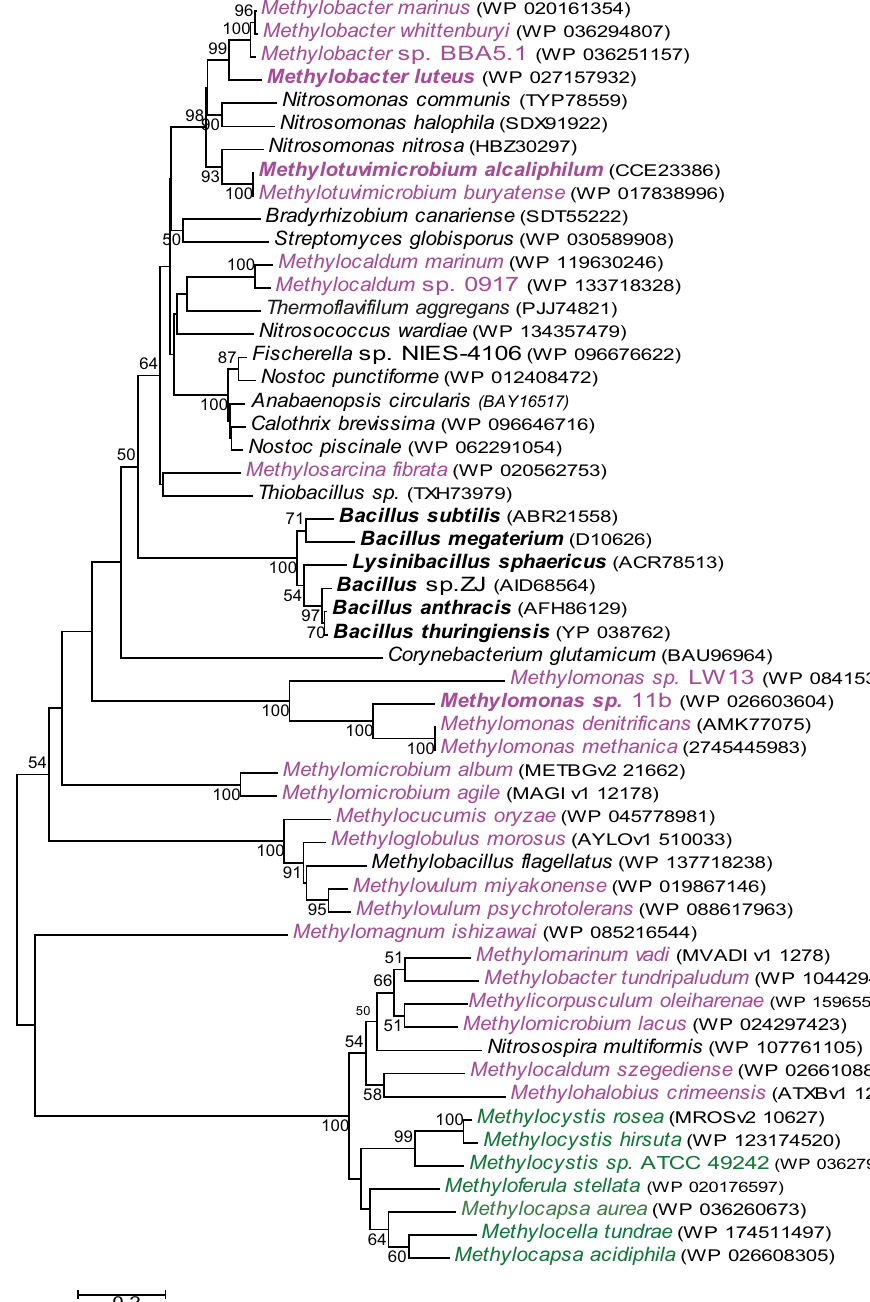
Figure 3. The phylogenetic tree built of the amino acid sequences of various putative and characterized bacterial NAD(P) + -dependent glucose dehydrogenases. The characterized enzymes are in bold: Bacillus thuringiensis 17 , Bacillus sp. ZJ 18 , Bacillus megaterium 19 , Bacillus subtilis 20 and Lysinibacillus sphaericus 21 . The amino acid accession numbers in the Gene Bank are in brackets. Gammaproteobacterial methanotrophs are purple colored, alphaproteobacterial methanotrophs are green colored. The scale bar corresponds to the number of substitutions per site. The sequences from NCBI, IMG/MER and MicroScope databases (http:// www. ncbi. nlm. nih. gov, https:// mage. genos cope. cns. fr/, https:// img. jgi. doe. gov/) were obtained by BLAST searches. The alignments of amino acid sequences and the phylogenetic analysis were performed using MEGA 6 and the Neighbor-Joining model 22